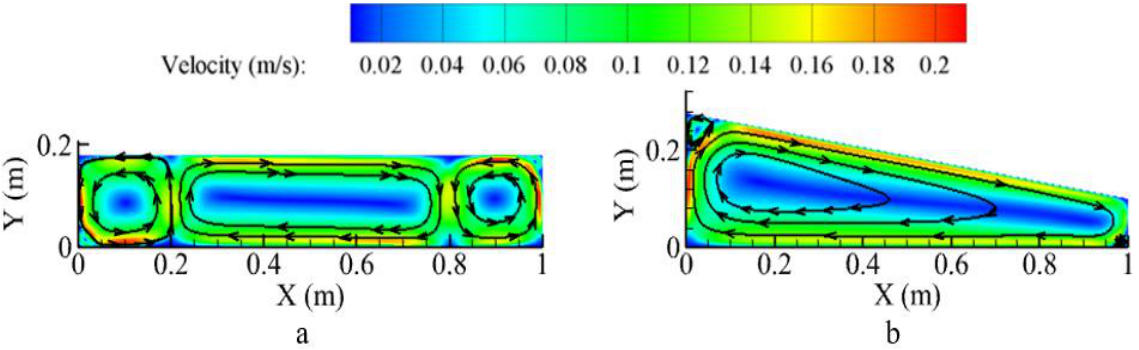
Figure 13. Velocity streamlines at AR = 5.52; ( a ) θ = 0°, ( b ) θ = 10°.